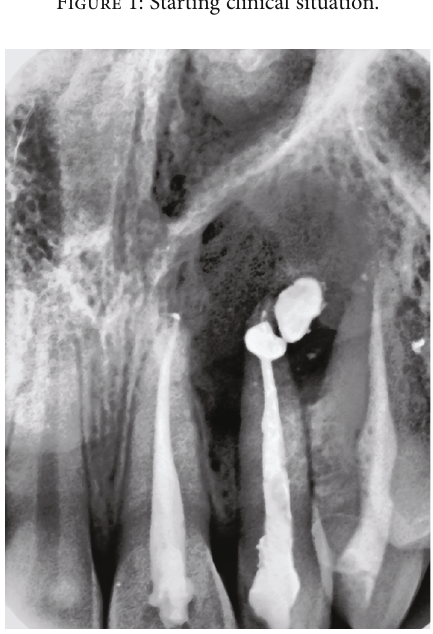
Figure 2: Starting